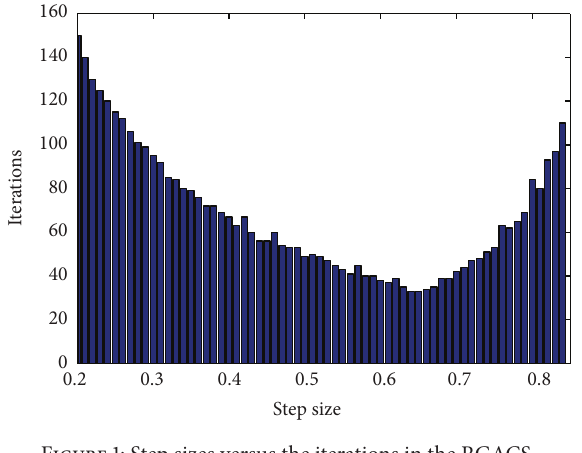
Figure 1: Step sizes versus the iterations in the